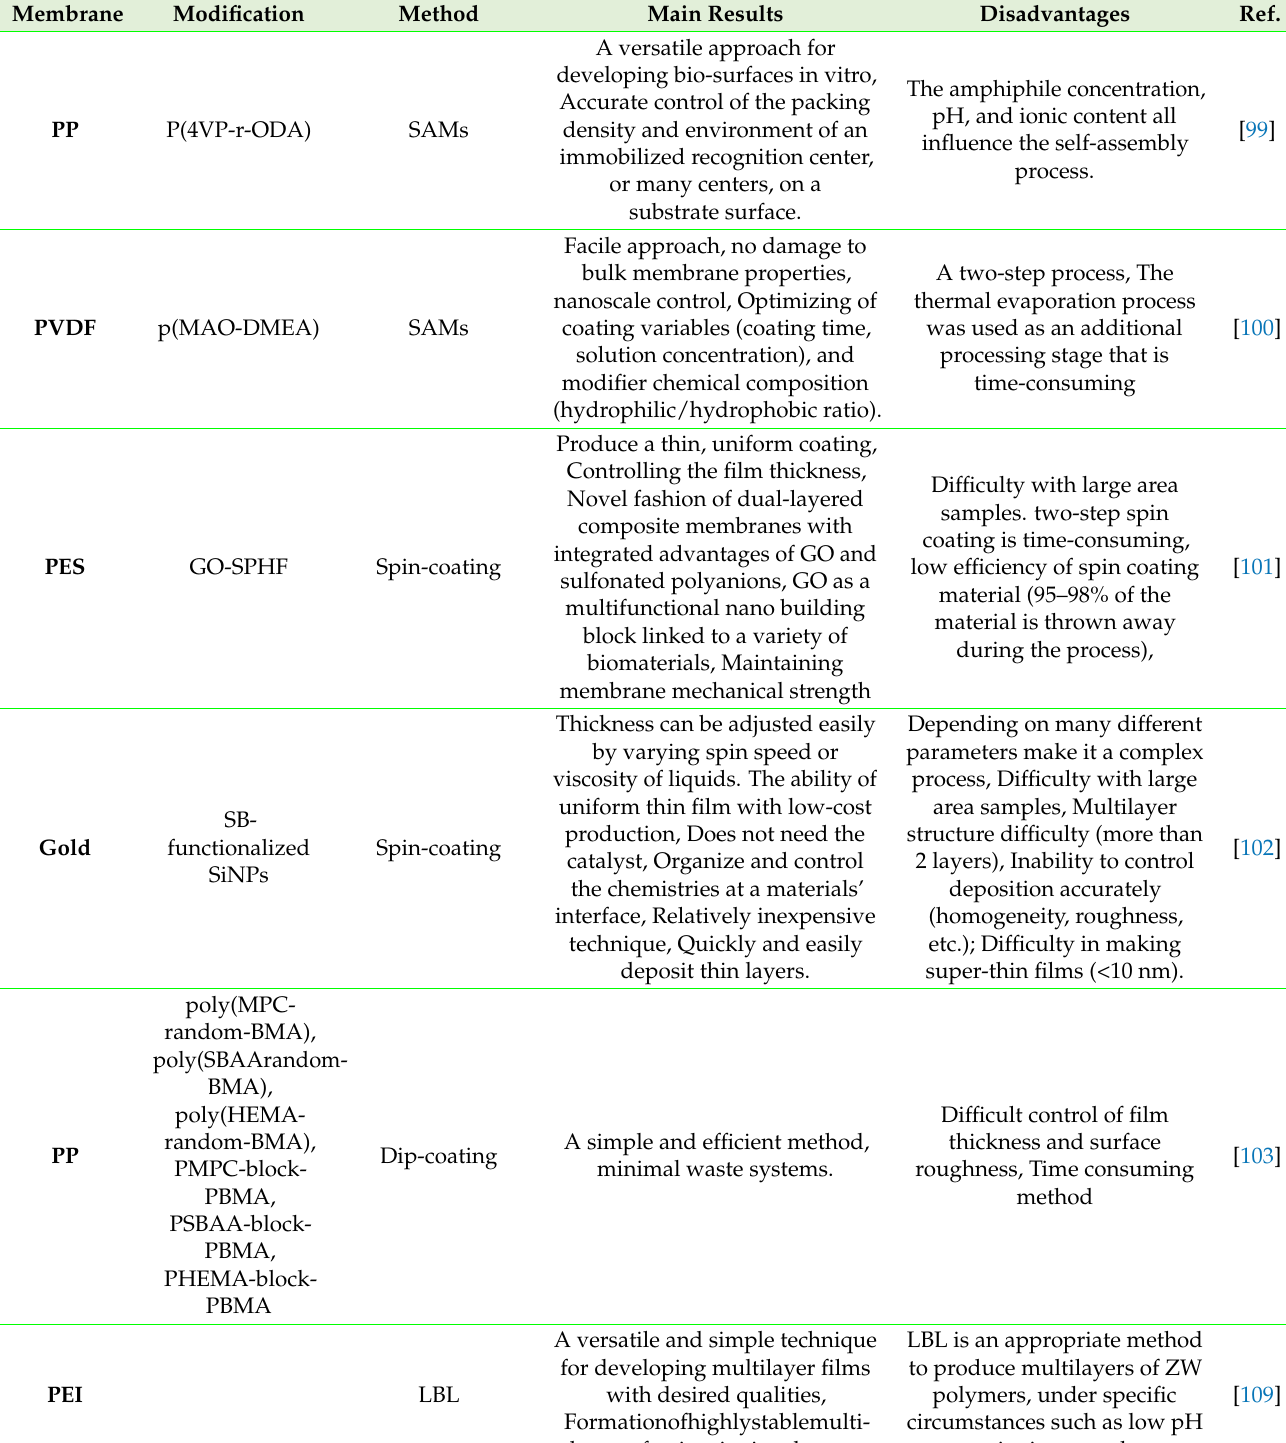
Table 2. Summary of selected surface-coating modification